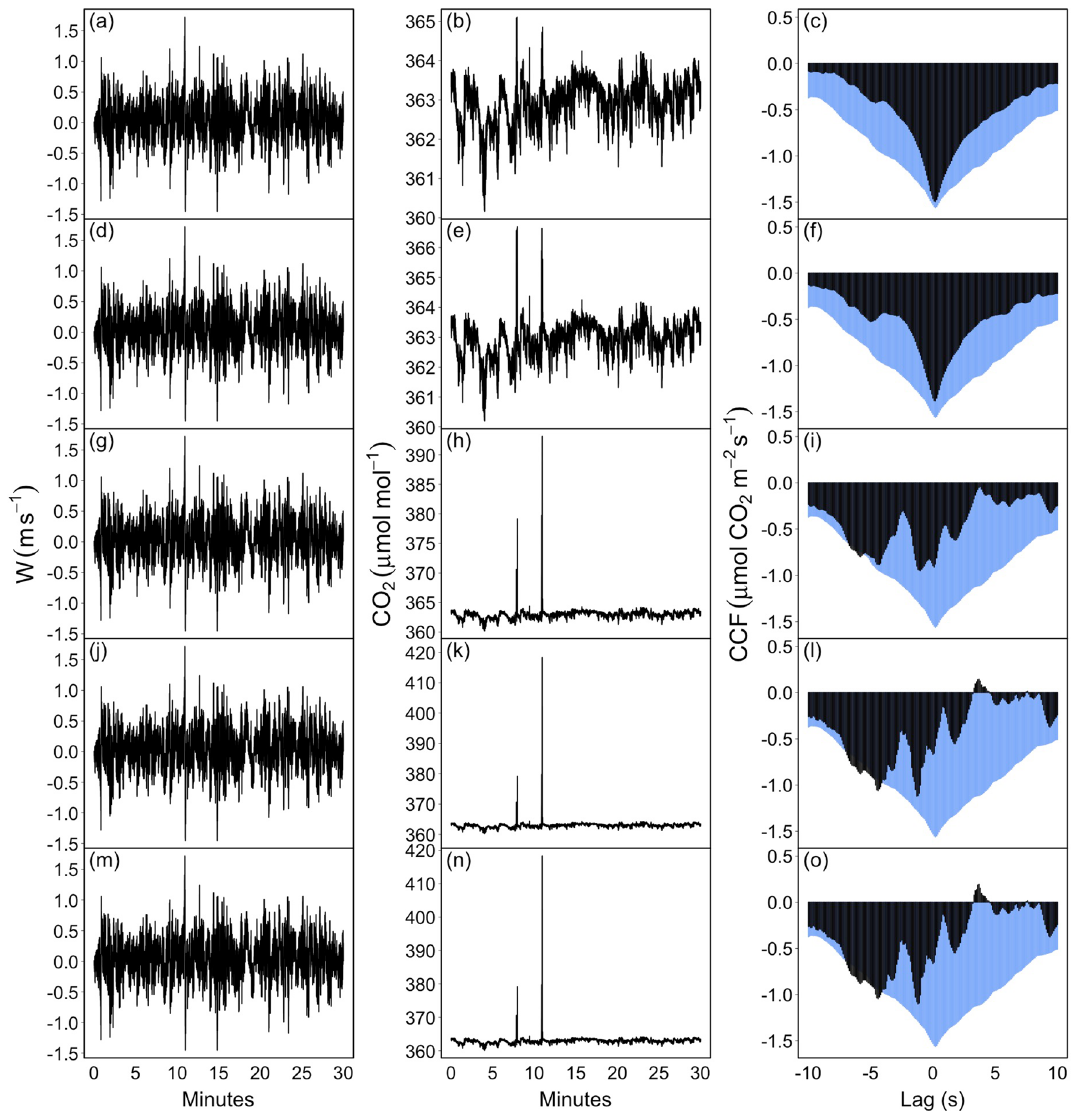
Figure 9. An application of despiking algorithms on real EC data from FI-Sii site: vertical wind speed ( w , 1 1 m s − , left panels), carbon dioxide concentration (CO 2 , µ mol mol − , middle panels), and their cross-covariance 2 1 function (CCF, µ mol CO 2 m − s − , right panels). ( a – c ) The despiked time series and their CCF after application of the RobF procedure. ( d – f ) The despiked time series and their CCF after application of the M13 algorithm. ( g – i ) The despiked time series and their CCF after application of the BR86 algorithm. ( j – l ) The despiked time series and their CCF after application of the VM97 algorithm. ( m – o ) The despiked time series and their CCF after application of the M12 algorithm. Original raw data are depicted in Fig. 8d,e. The blue colored CCF on the right panels refers to the one estimated in the subsequent 30 min and is used as a reference (see Fig.